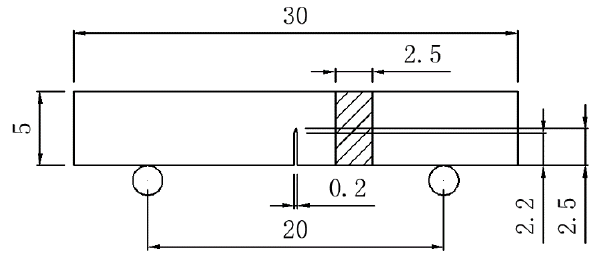
Figure 1. A schematic diagram of specimens for three point bending testing (unit: mm).